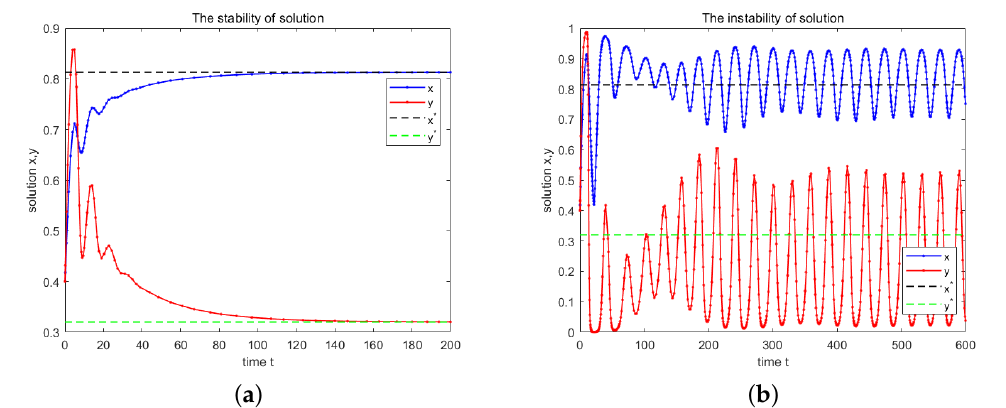
Figure 3. ( a ) The stability of the mixed ESS when τ 1 = 2, τ 2 = 3, τ 3 = 4, τ 4 = 5 time units. ( b ) The stability of the mixed ESS when τ 1 = 9, τ 2 = 10, τ 3 = 11, τ 4 = 12 time units, where p 0 = 0.4, p 1 = 0.2,